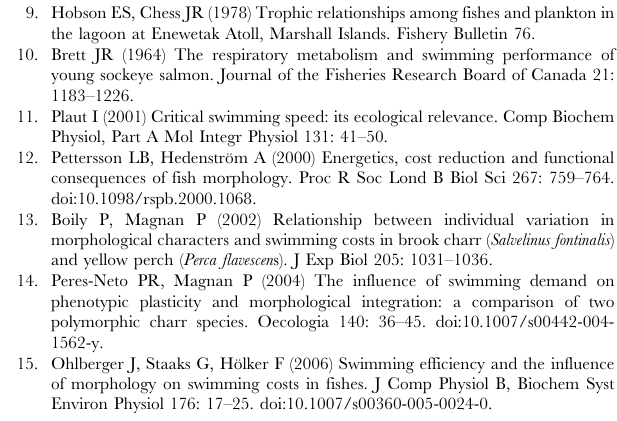
Table S1 Morphometric and performance data for the 55 pectoral fin swimmers and 29 body-and-caudal fin